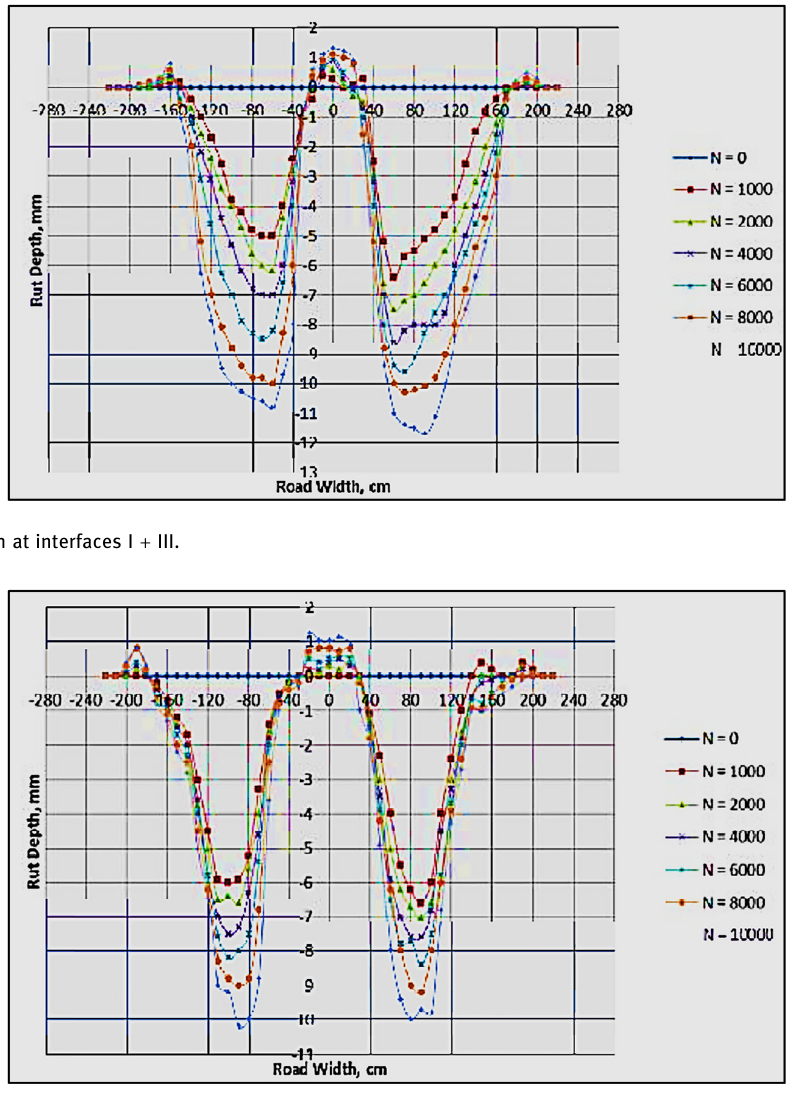
Figure 17: Rutting depth at interfaces II + III.